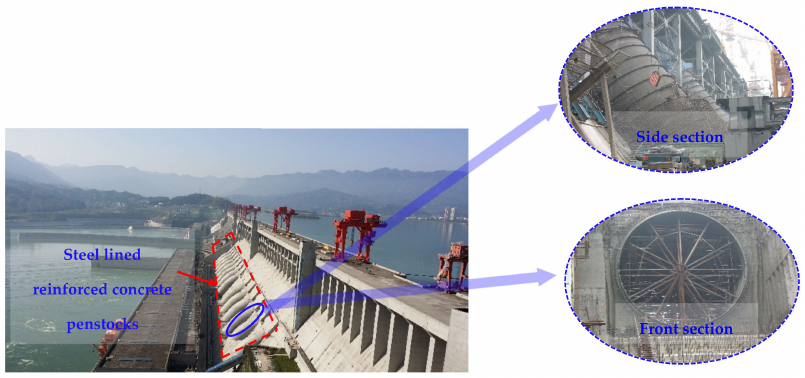
Figure 2. Steel-lined reinforced concrete penstock of the Three Gorges HPP.